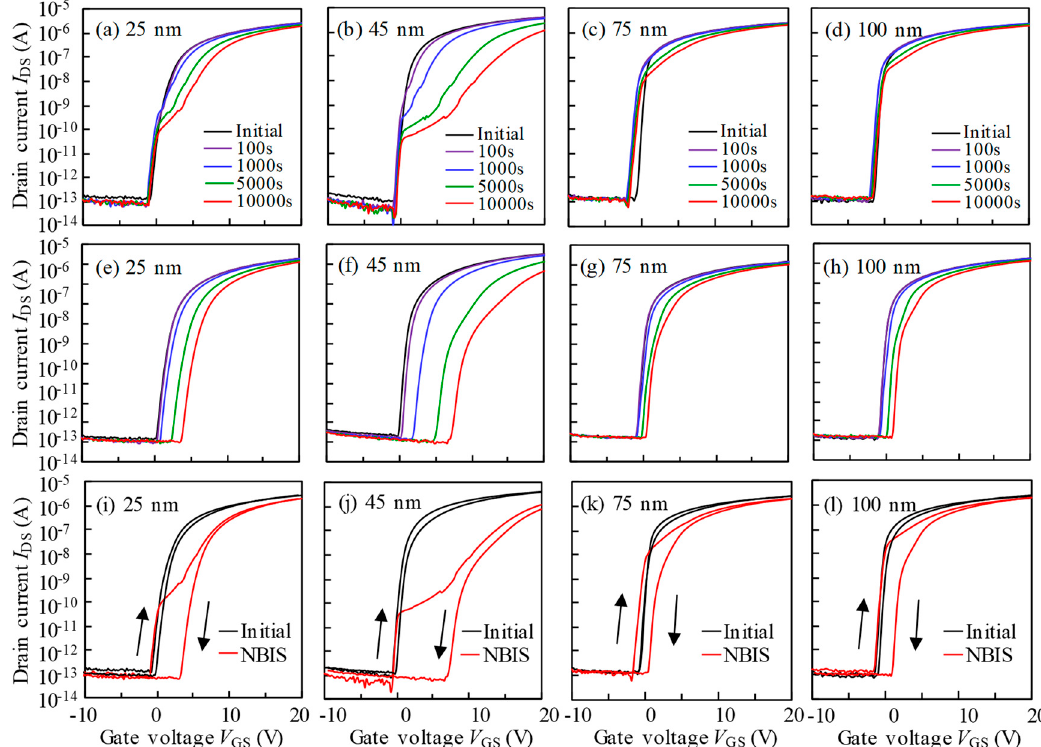
Figure 3. Evolution of transfer curves of TFTs with the T ITZO of ( a ) 25, ( b ) 50, ( c ) 75, and ( d ) 100 nm in the forward scan, and the devices with thickness of ( e ) 25, ( f ) 50, ( g ) 75, and ( h ) 100 nm in the reverse scan as a function of NBIS duration. The whole transfer curves in the beginning and after NBIS stress of TFT devices with the T ITZO of ( i ) 25, ( j ) 50, ( k ) 75, and ( l ) 100 nm, respectively.